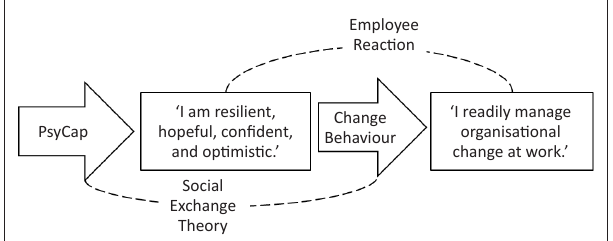
FIGURE 3: The social exchange theory at work in the